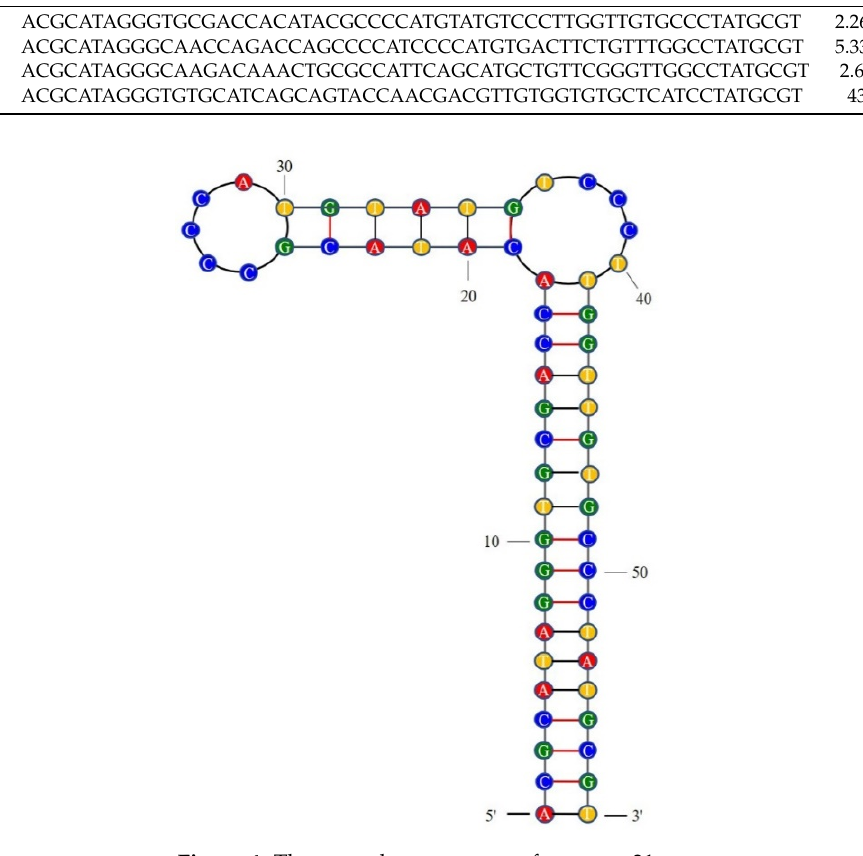
Figure 4. The secondary structure of aptamer 31.